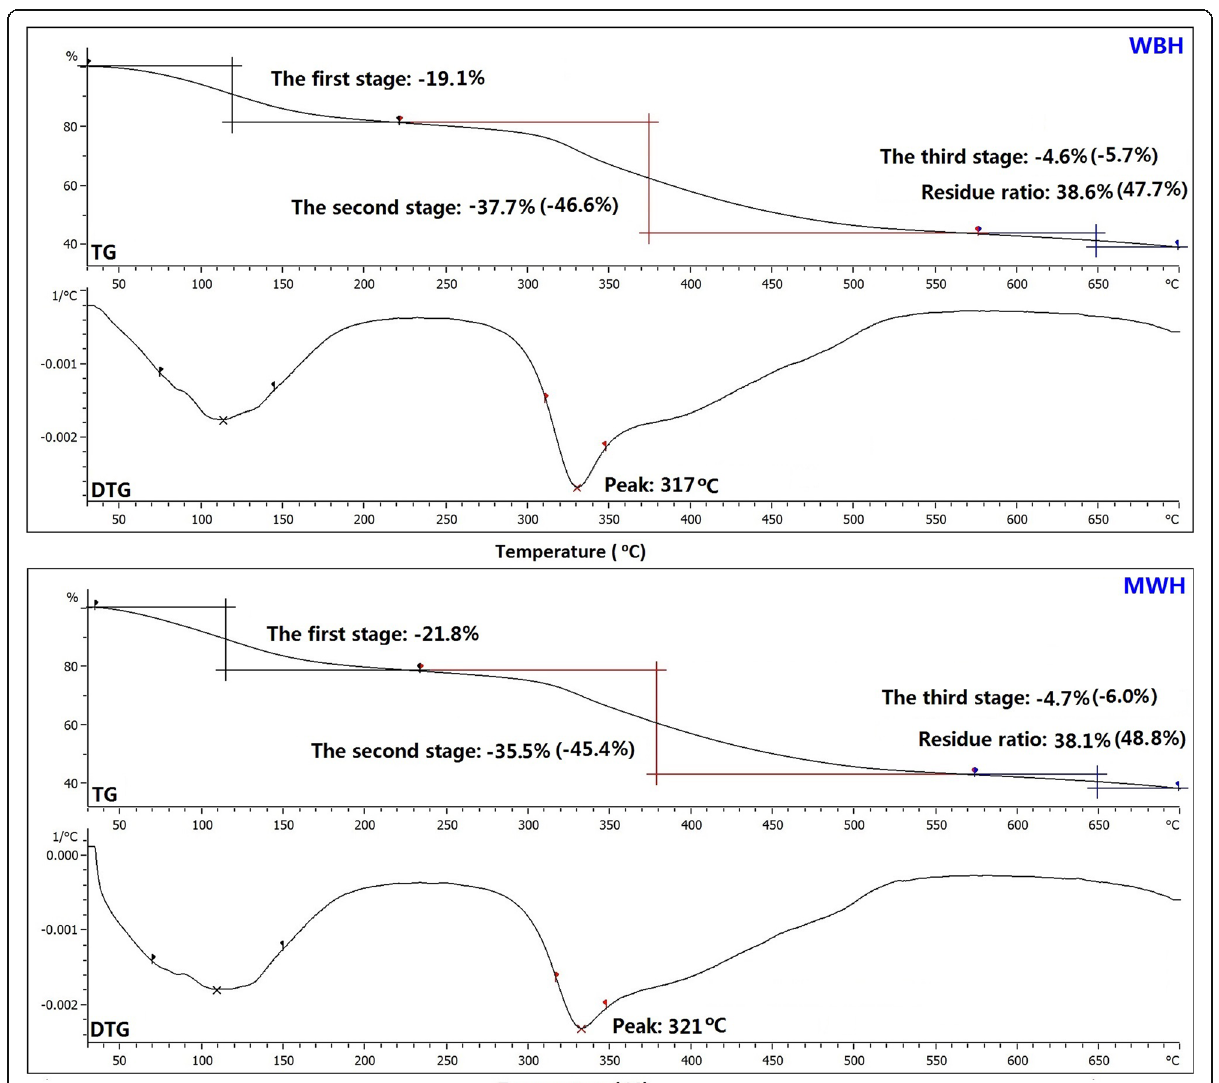
Fig. 5 TG/DTG curves of aluminum tanned skin pieces under different heating